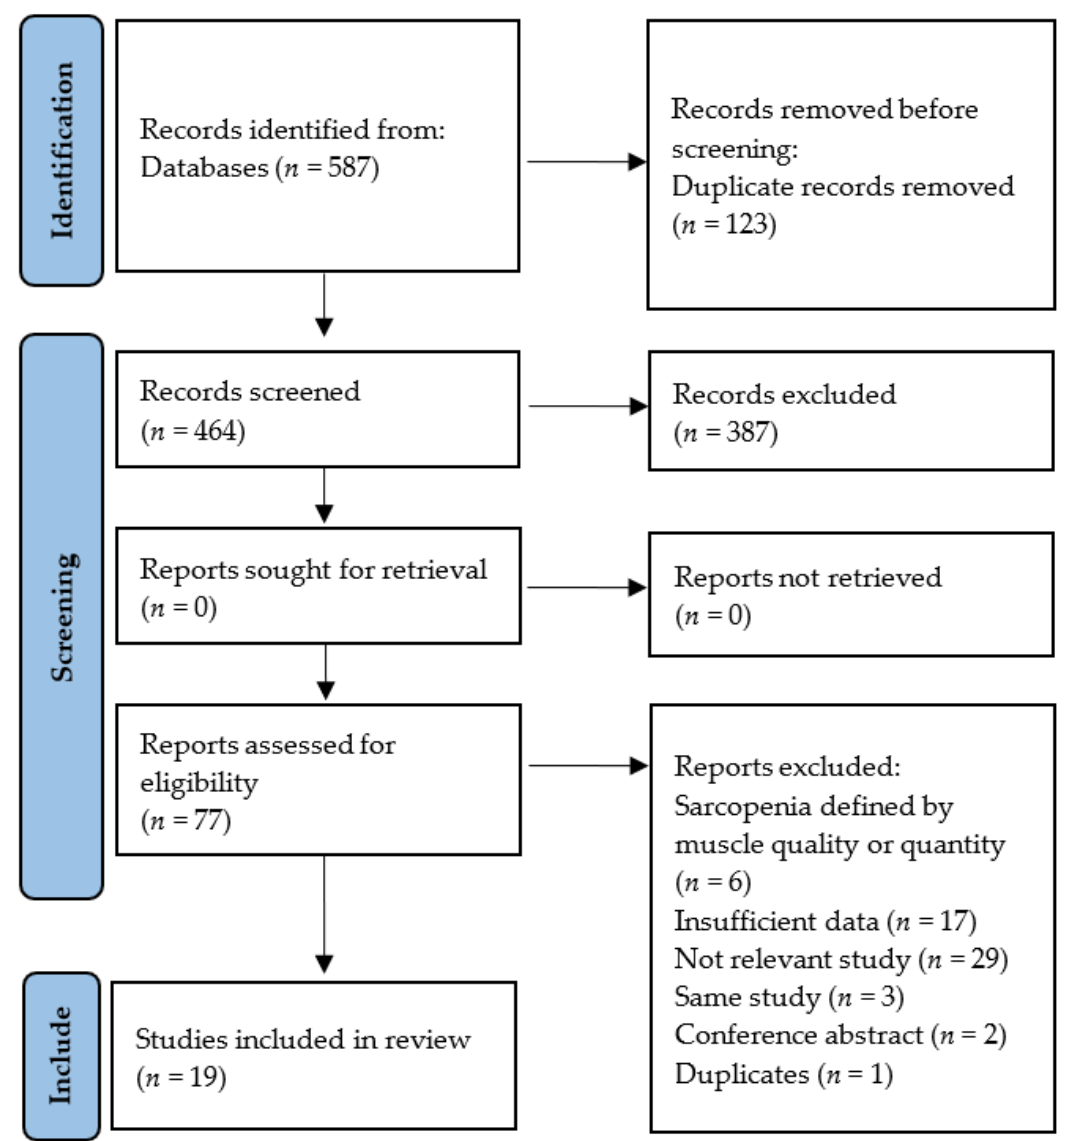
Figure 1. PRISMA 2020 flow chart of the article selection. Abbreviation: PRISMA, Preferred Reporting Items for Systematic Review and Meta-Analysis.